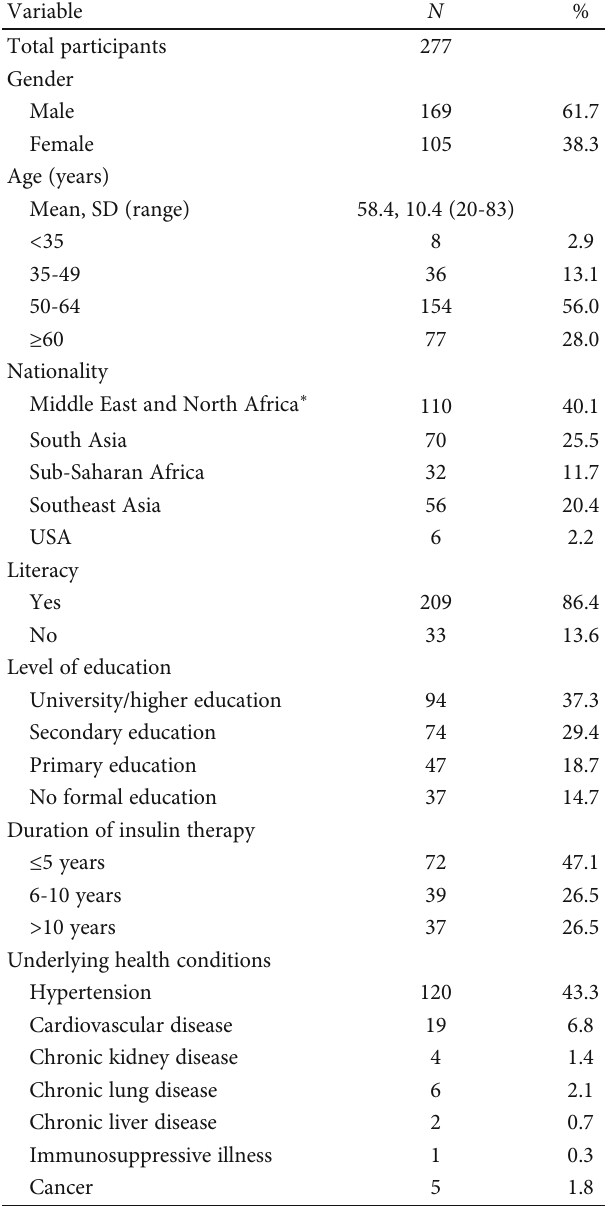
Table 1: Characteristics of the study